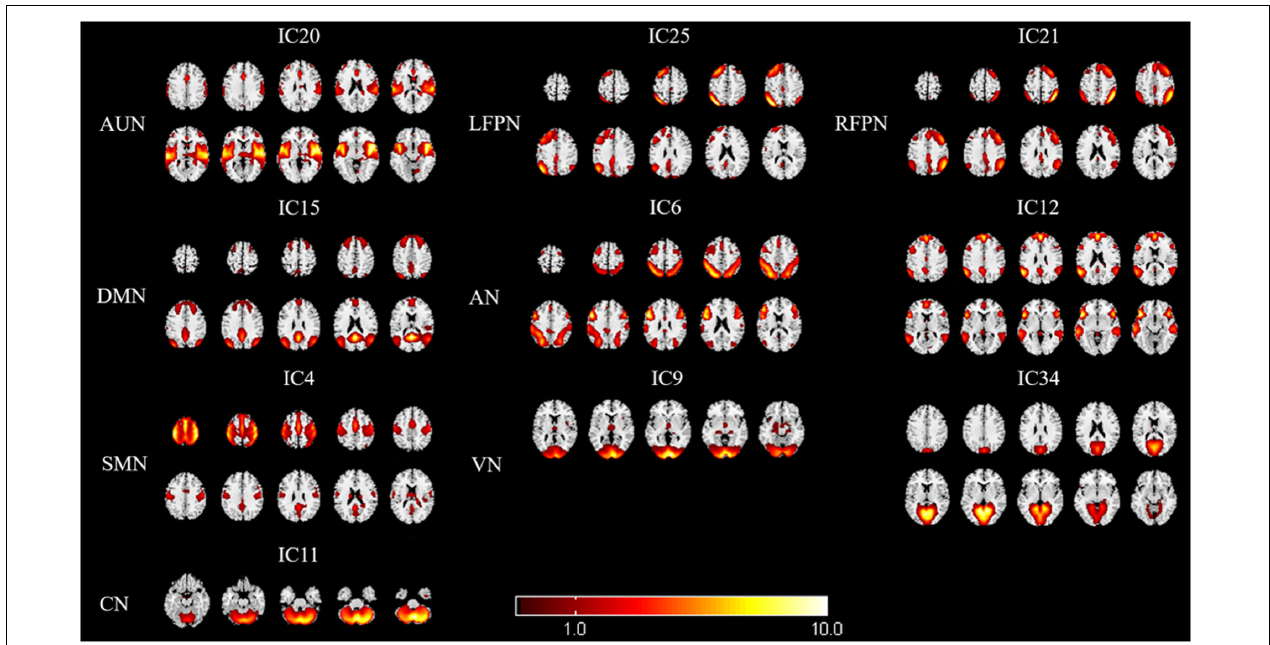
FIGURE 2 | Spatial maps of identified resting-state networks (RSNs) are divided into eight different functional domains, namely, AUN, LFPN, RFPN, DMN, AN, SMN, VN, and CN. AUN, auditory network; LFPN, left frontoparietal network; RFPN, right frontoparietal network; DMN, default mode network; AN, attention network; SMN, sensorimotor network; VN, visual network; and CN, cerebellum network.